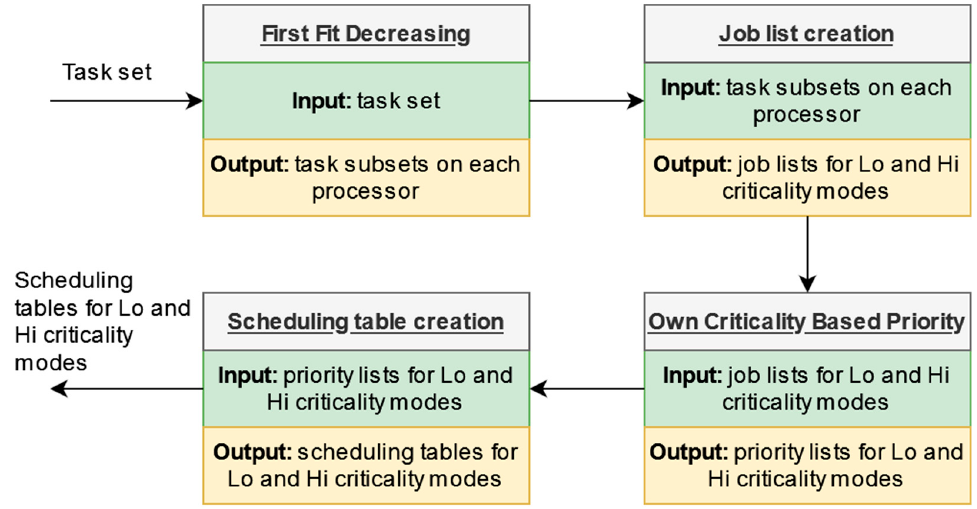
Figure 1. System execution flowchart.